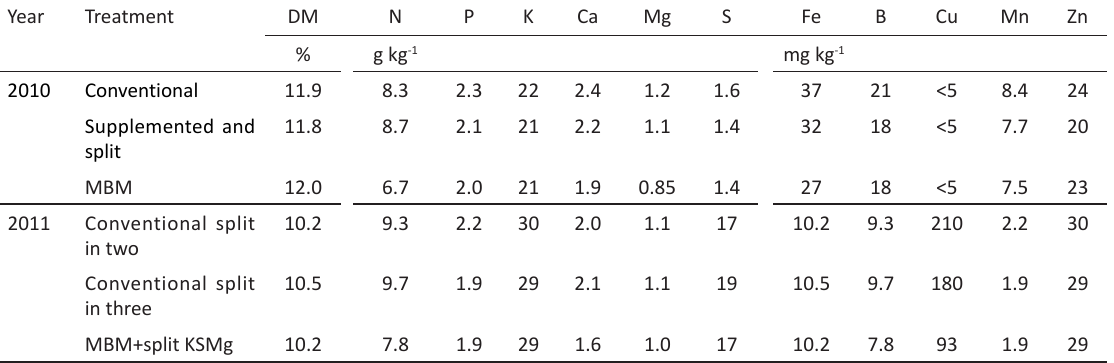
Table 11. Nutrient contents of carrots harvested in 2010 and 2011 Year